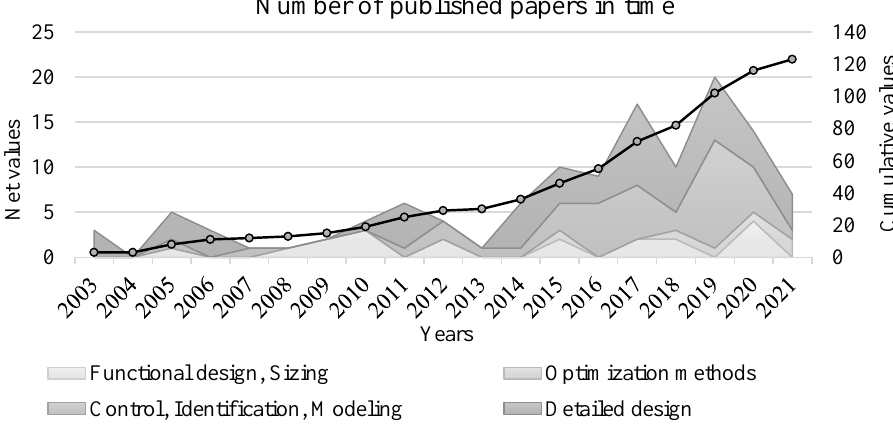
Cumulative function Figure 2. For each category, the number of published papers over time is plotted in stacked style. In the black line, the cumulative